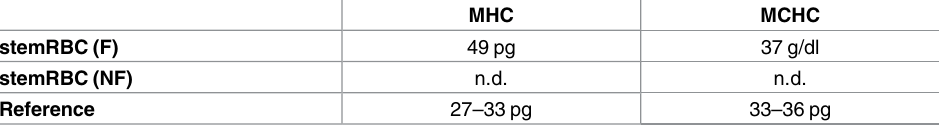
Table 3. MCH and MCHC values of stemRBCand control RBC. Filtered (F) stemRBCs (Day 18) along with reference values for control RBCs obtainedfrom MedlinePlus.Mean, (n =